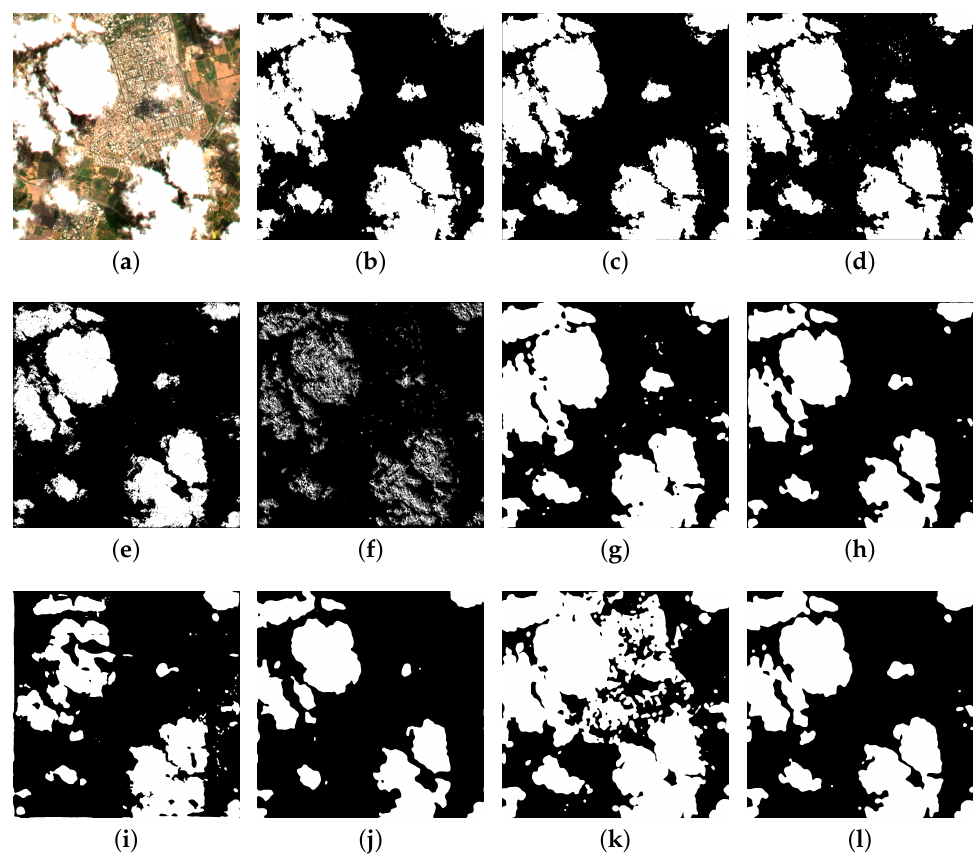
Figure 11. Binary detection of clouds on a patch of an S01 VEN µ S tile from various